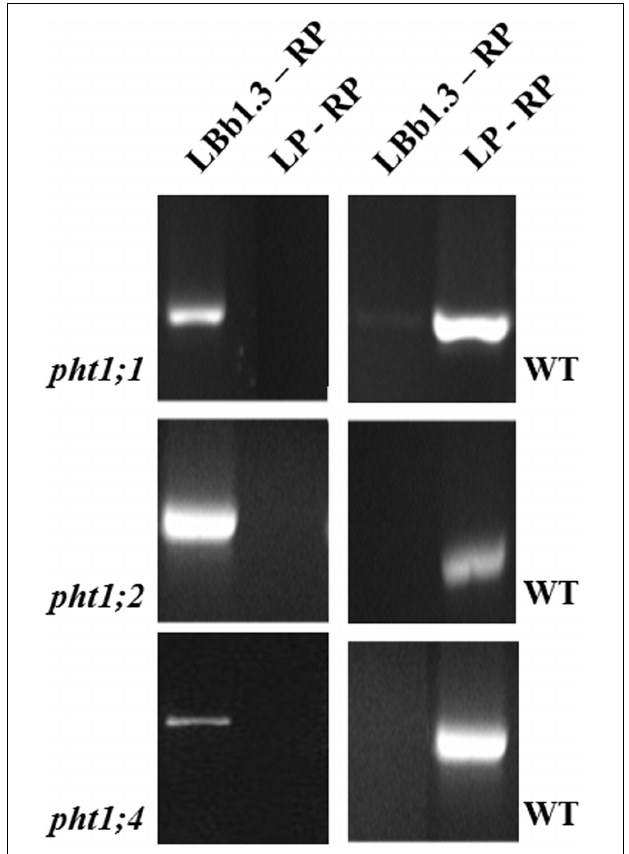
FIGURE 4 | Homozygosity test for pht1;1 , pht1;2 , and pht1;4 by PCR. Only one plant per knock-out line is shown. The gene-specific primers LP (left primer) and RP (right primer) amplify the expected fragments for the PHT1;1 , PHT1;2 , and PHT1;4 genes in DNA preparations from WT plants, which is used as a positive control. The T-DNA specific primer LBb1.3 (TGGTTCACGTAGTGGGCCATCG) in combination with the gene-specific RPs (cf. Supplementary Table S1) amplifies a PCR fragment only when the T-DNA is inserted into the respective gene close to the RP. The PCR samples were run on a 1% agarose gel next to a size ladder and the predicted sizes of the fragments were confirmed.